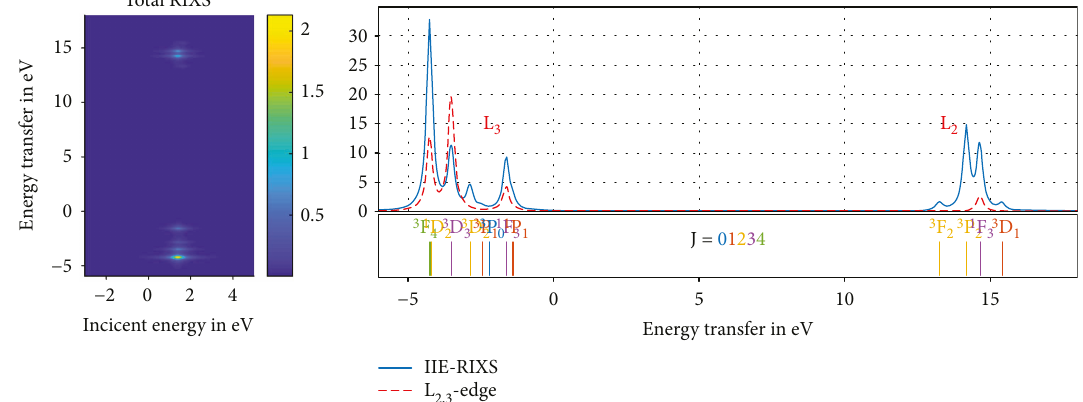
Figure 17: Calculated 1s2p RIXS for an isolated Ni 2+ ion (3d 8 ) representing the atomic case. The projection of the total 1s2p RIXS map onto the energy transfer axis is shown together with the 2p XAS (L